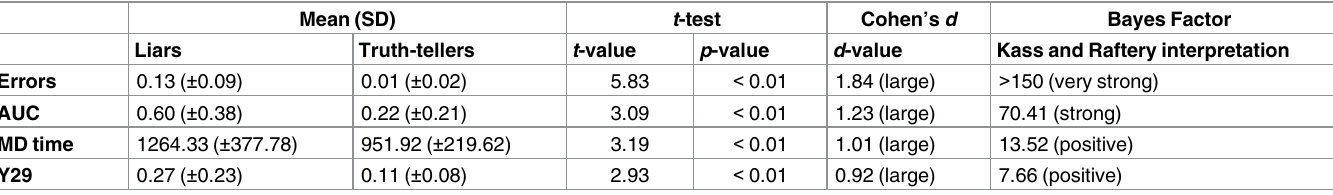
Table 3. Descriptivestatistics of the 13 independent